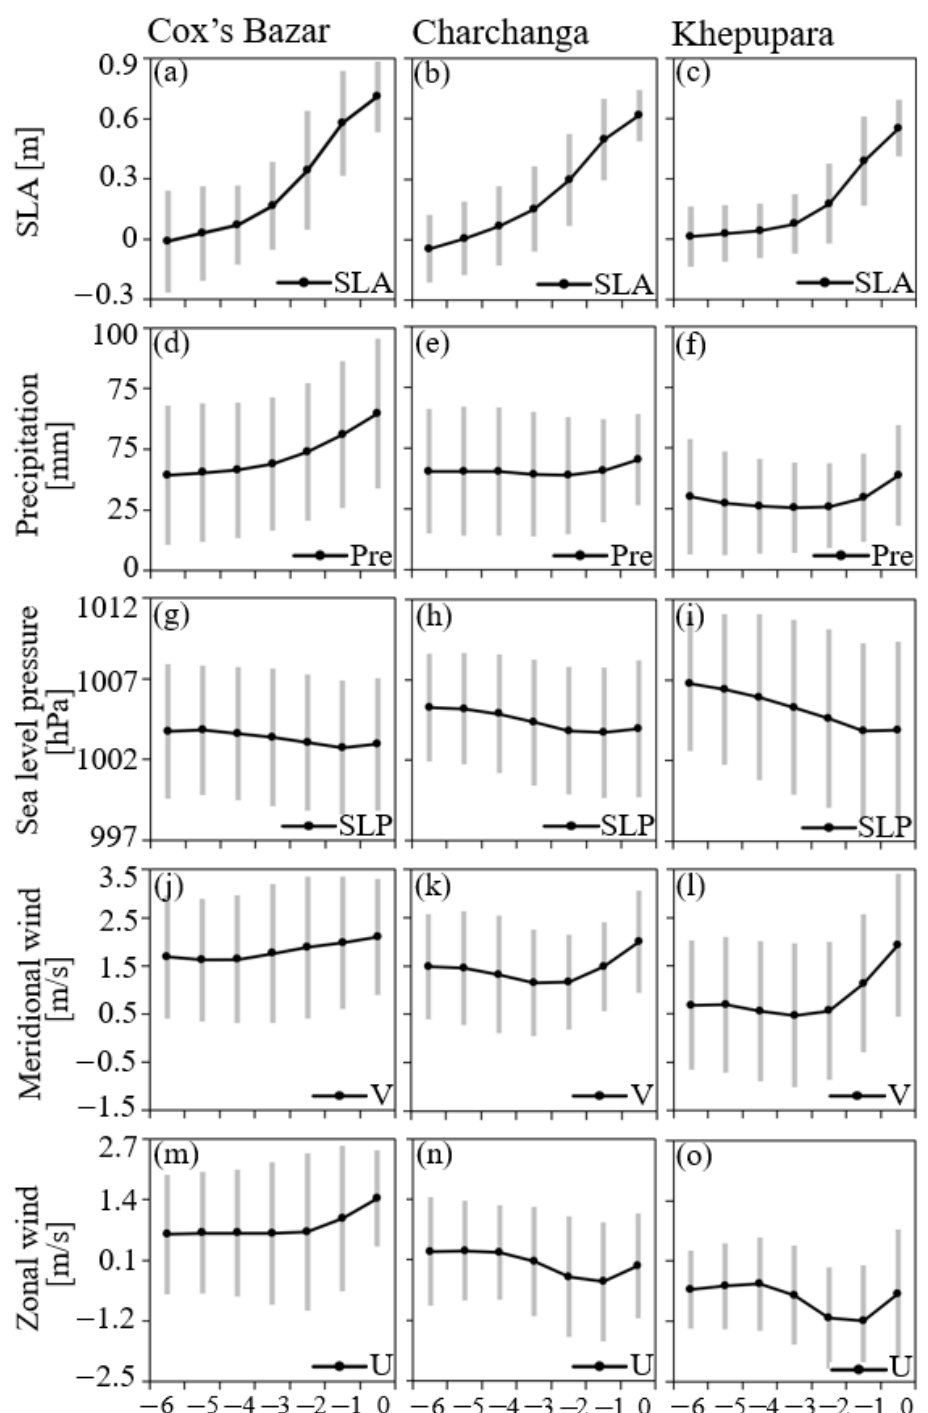
Figure 6. The average time series (line) of SLA, Pre, SLP, U, and V for all ESL events at Cox’s Bazar ( a , d , g , j , m ), Charchanga ( b , e , h , k , n ), and Khepupara ( c , f , i , l , o ). The error bars represent the standard deviation of the cases. The values on the x-axes represent the day, ranging from −6 to 0, correspond- ing to six days before ( t = −6) the targeted day of the ESL event ( t = 0). Similarly, a composite spatial distribution of meteorological variables has been pre- sented for ESL events at Cox’s Bazar. The composite analysis was performed for the pe- riod of 1993 – 2006, considering the availability of SLA data. Please note that the definition of sea level anomaly for the daily gridded data, which represents the deviation of the daily sea level from 20-year mean, was different from the one used for the station data (Section